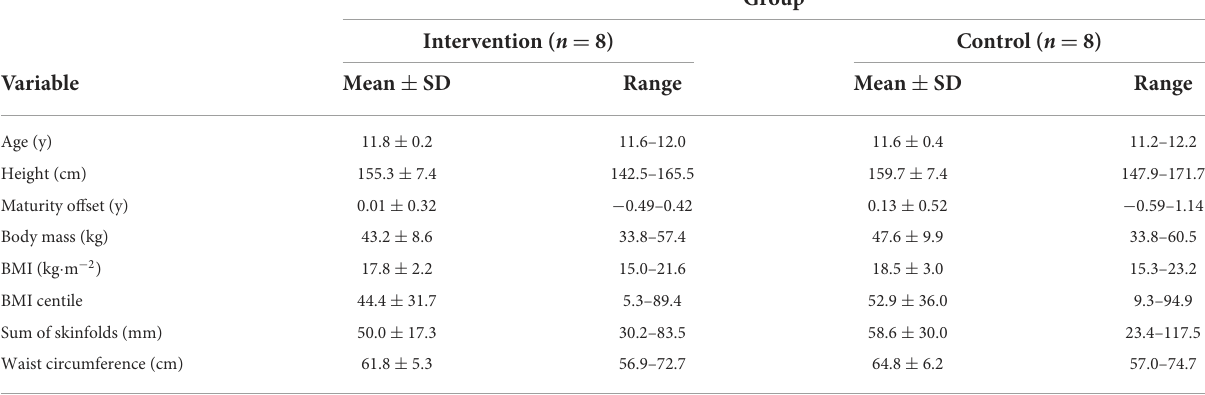
TABLE 1 Descriptive summary of baseline participant characteristics for the intervention and control